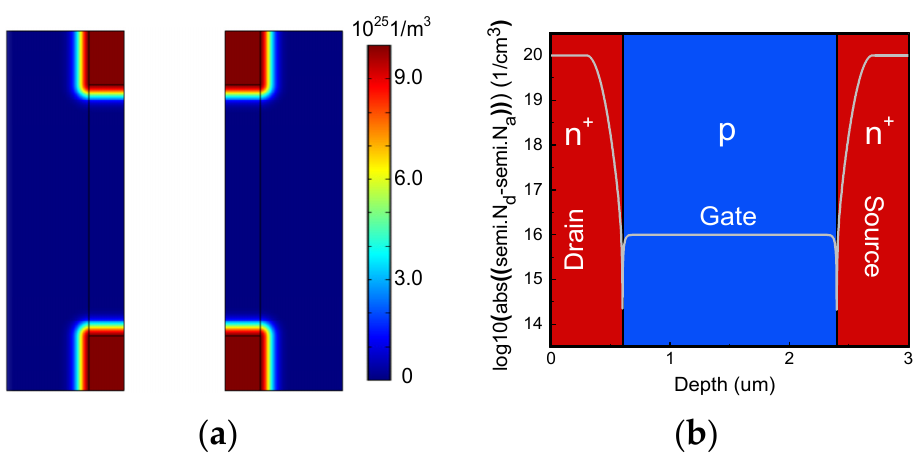
Figure 5. ( a ) The section of n-type ion doping; ( b ) distribution curve of N d and N a with respect to doping depth.